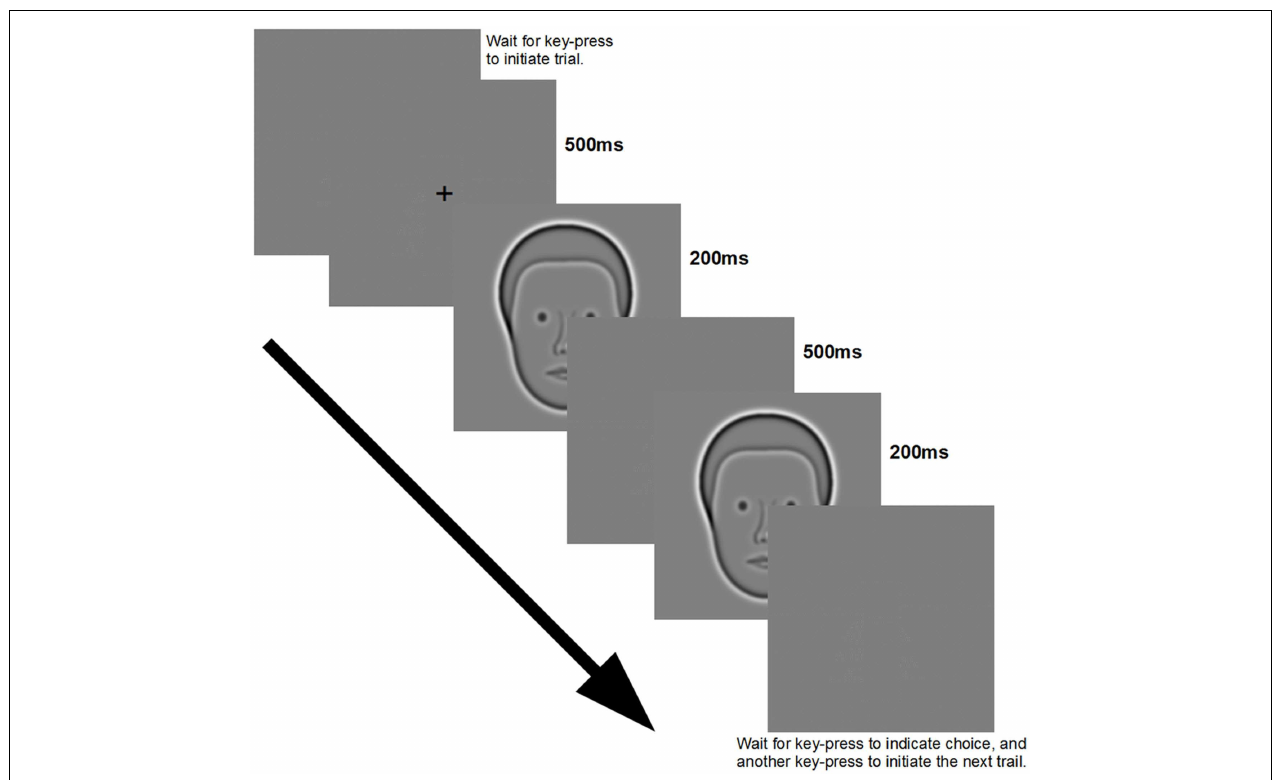
FIGURE 2 | Presentation sequence and image display duration used for all